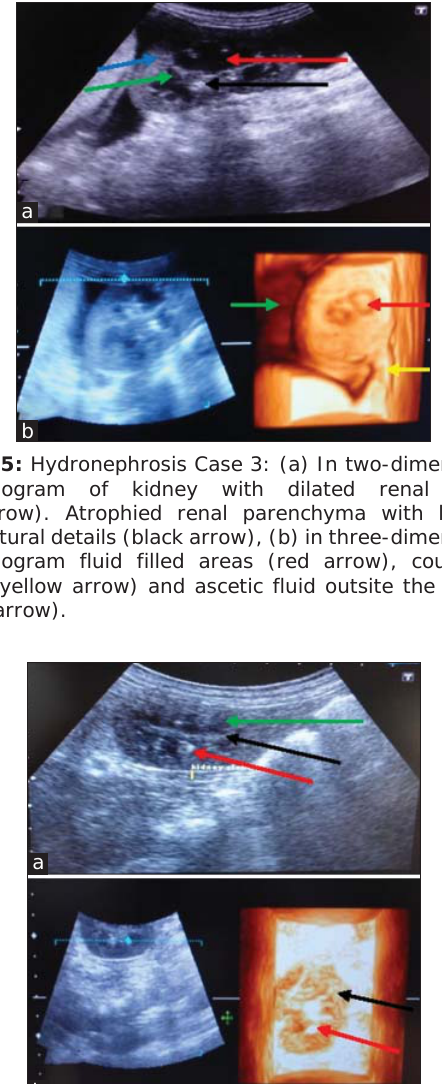
ba Figure-6: Nephrolithiasis: (a) In two-dimensional ultrasonogram of kidney the nephrolith is clearly visible (red arrow). The architectural details showing renal crest (black arrow) and divarticulae (green arrow), (b) in three- dimensional ultrasonogram of kidney the nephrolith (red arrow) and renal parenchyma (black arrow).